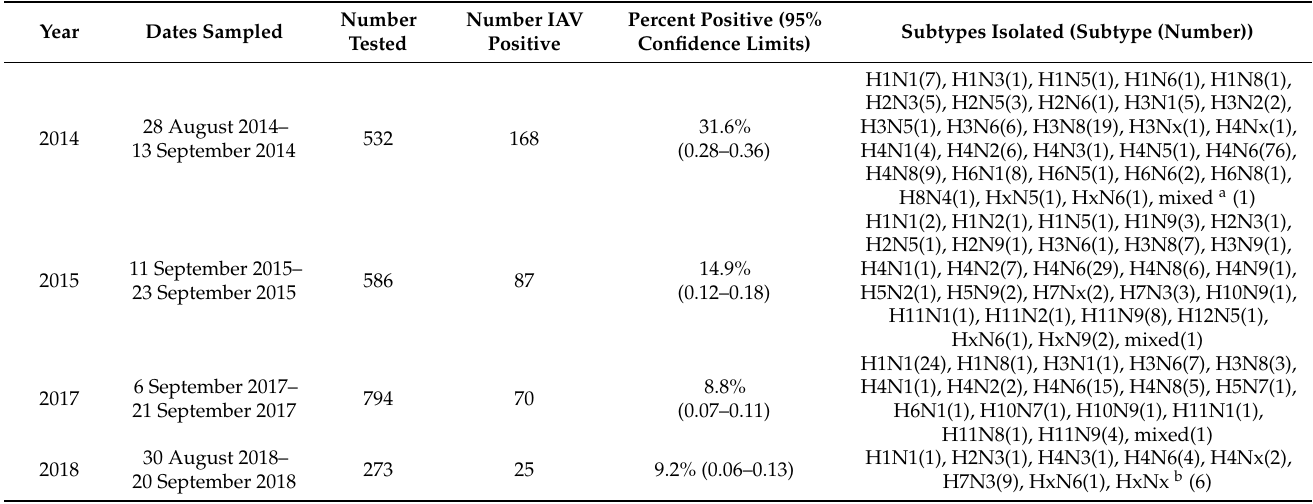
Table A1. Virus isolation results from Mallards sampled in Northwest